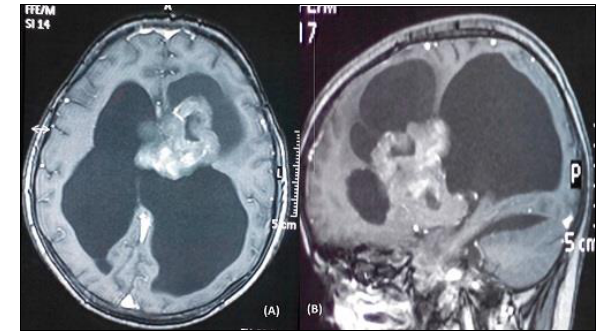
Figure 3: figures, contrast T1-weighted axial (A) and sagittal (B) magnetic resonance images of a child showing an intraventricular contrast enhancing lesion with hydrocephalus, features compati- ble with of choroid plexus papilloma.